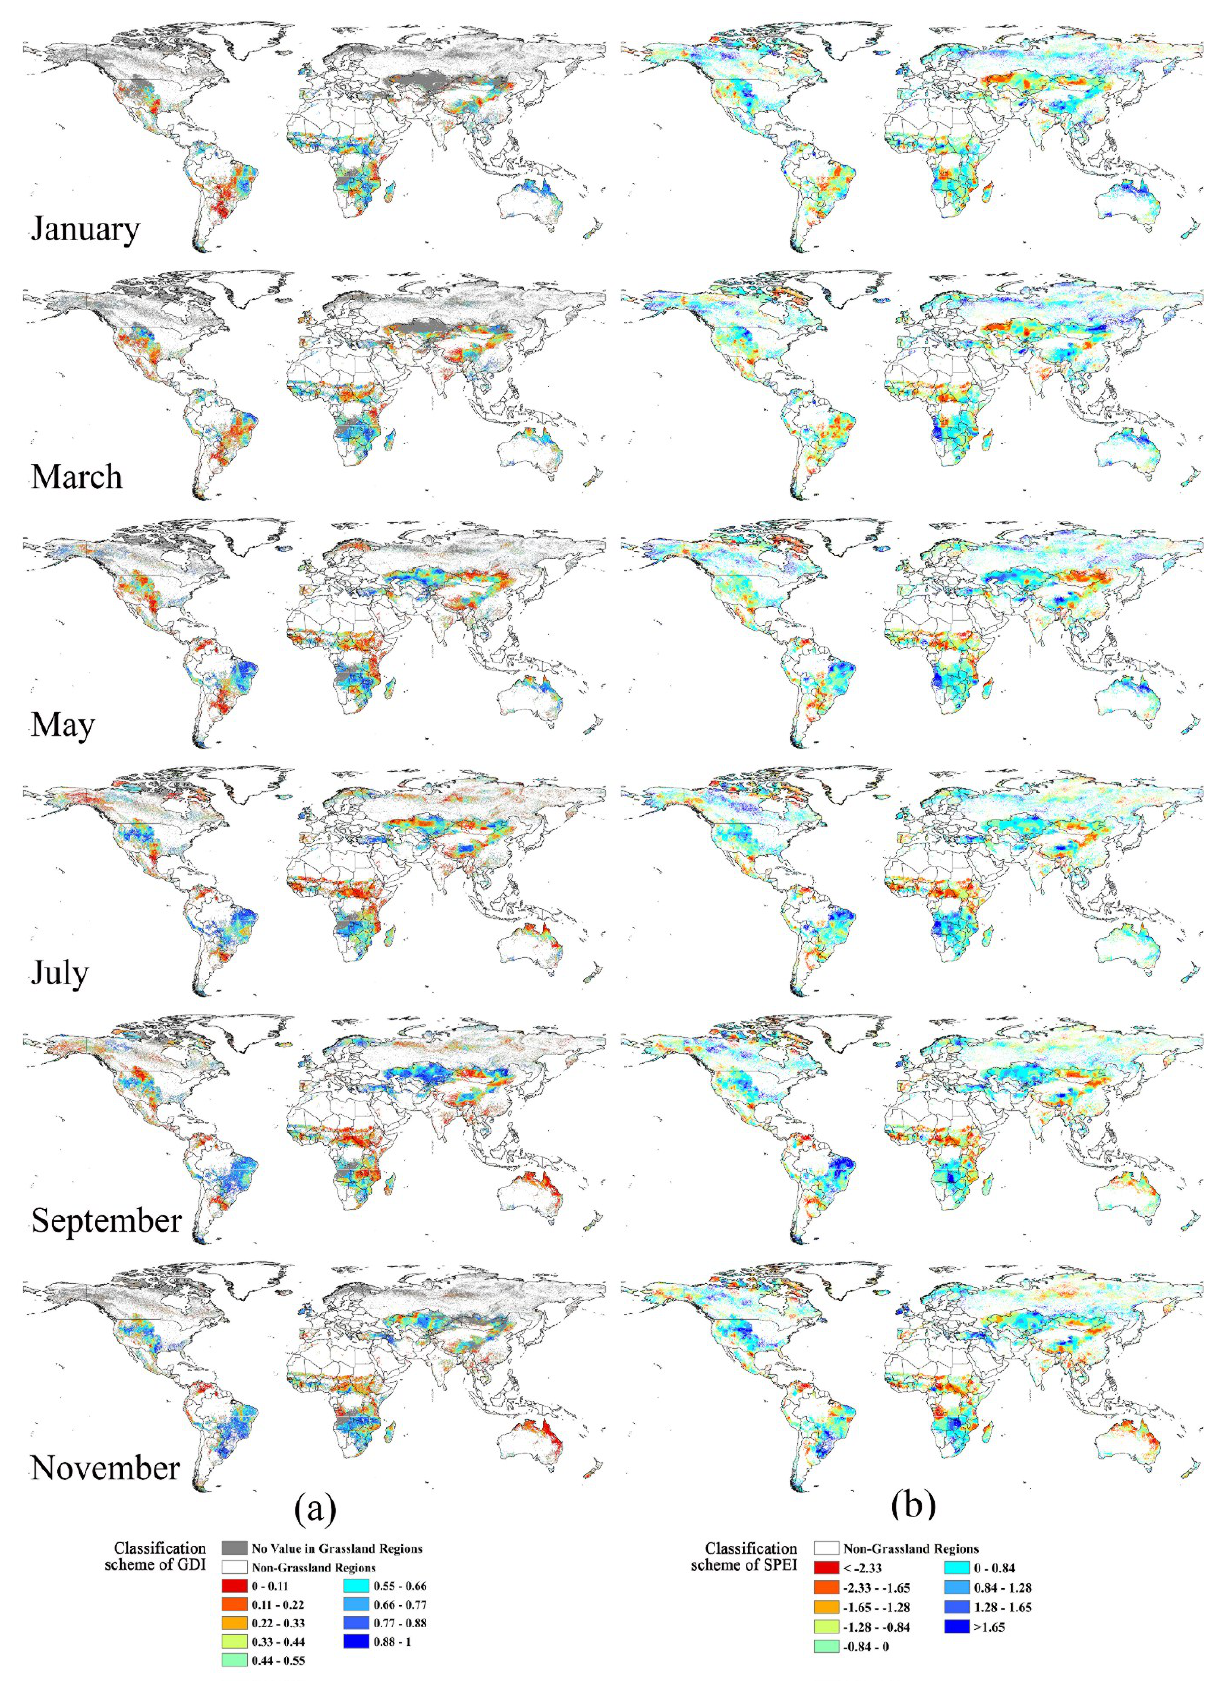
Figure 11. The global distribution of the GDI-6CRU and SPEI-6mon for grassland regions in different months of 2009. ( a ) GDI-6CRU; ( b )